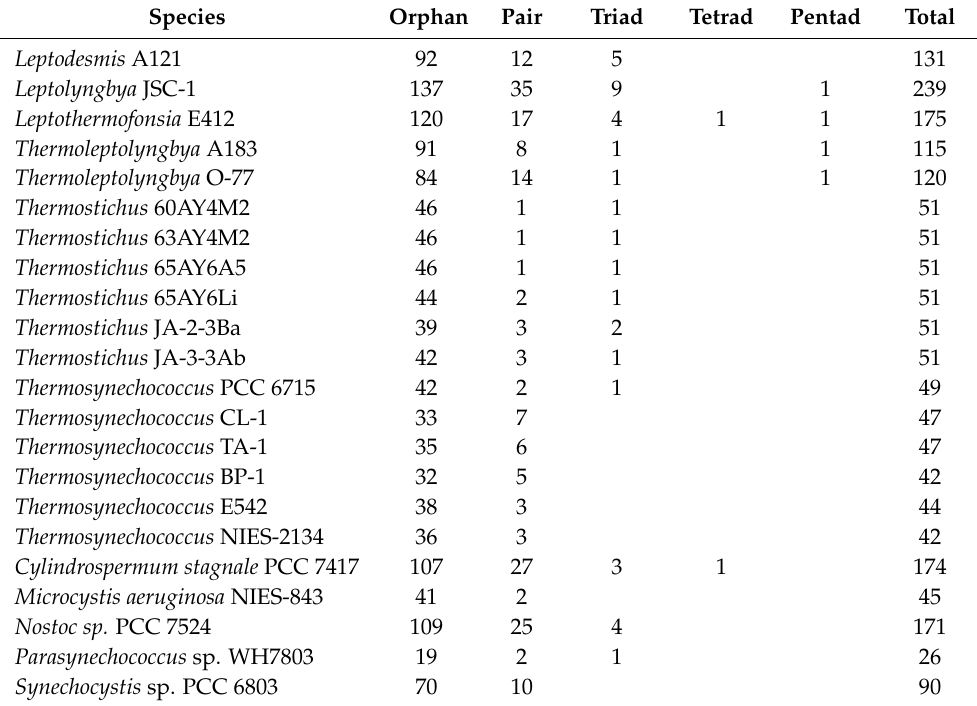
Table 2. Genetic organizations of TCS genes in thermophilic and reference